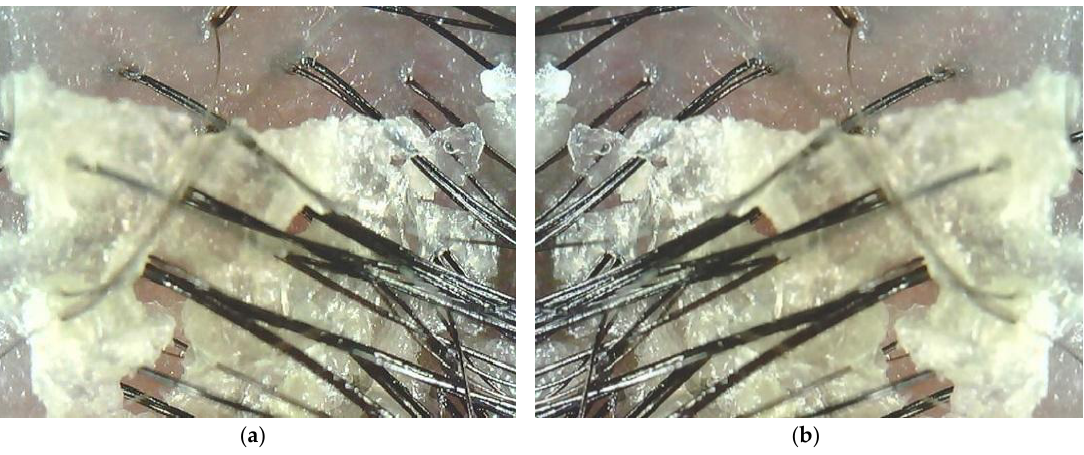
Figure 10. ( a ) Scalp before flipping; ( b ) scalp after flipping.